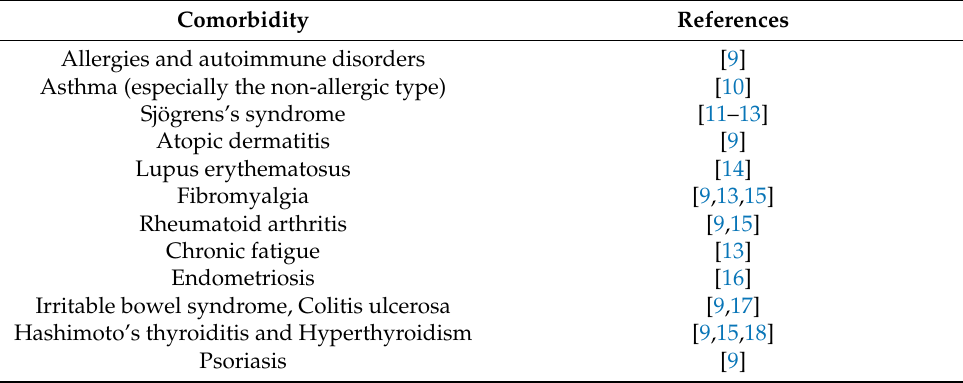
Table 1. Diseases overrepresented and frequently associated with